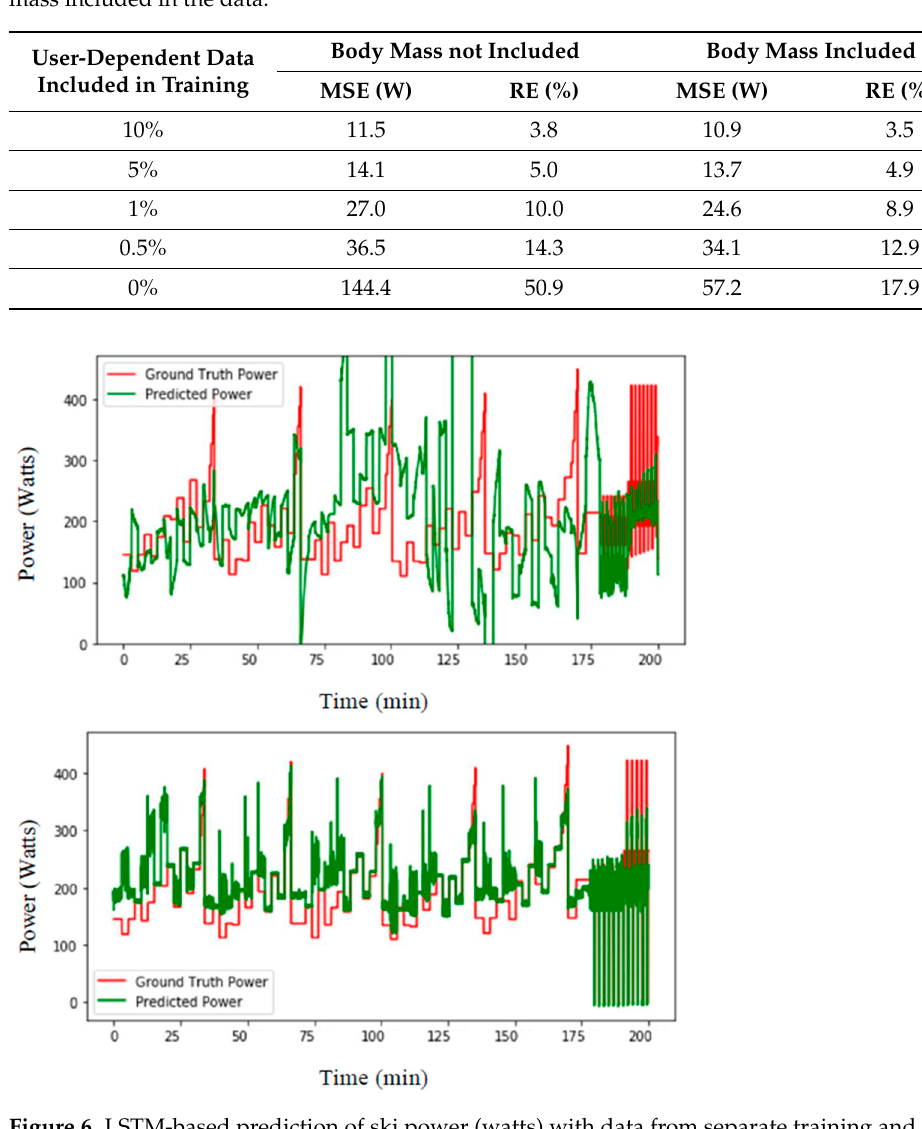
Figure 6. LSTM-based prediction of ski power (watts) with data from separate training and testing subjects ( top ) excluding and ( bottom ) including masses of the athletes where no data from the testing subjects were introduced in training.